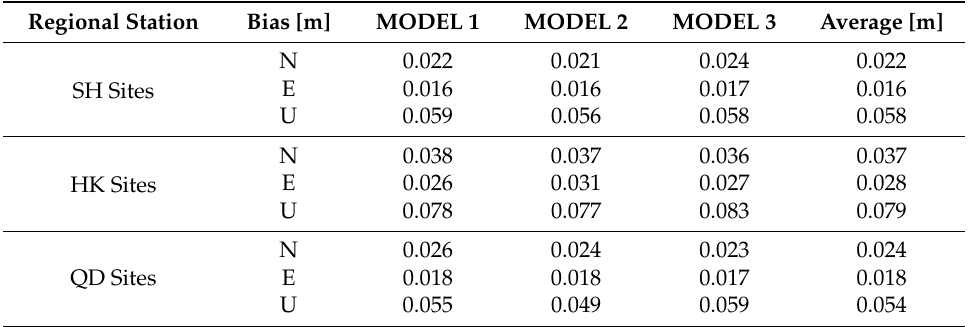
Table 6. Statistical sheet for RTPPP-AR positioning accuracies of different regional stations in different